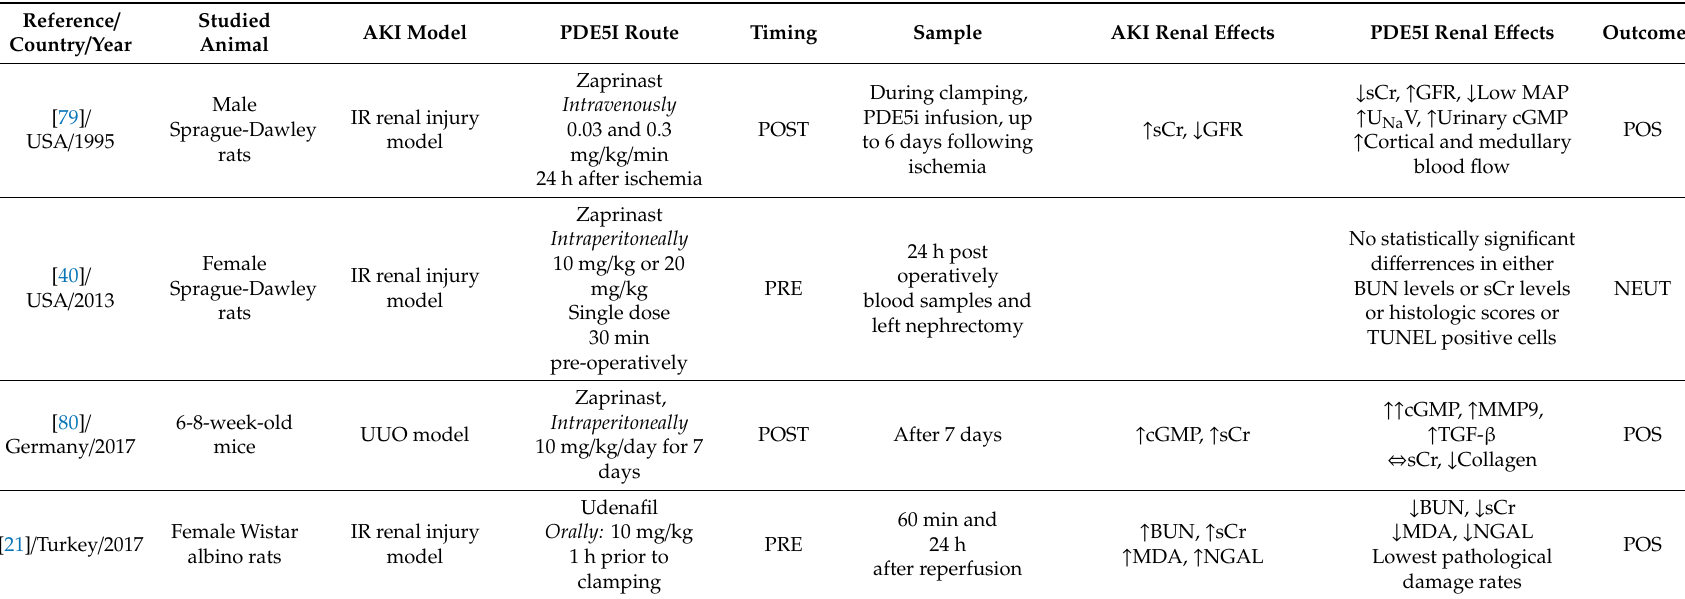
Table 6. Animal studies evaluating the potential reno-protective e ff ects of zaprinast and